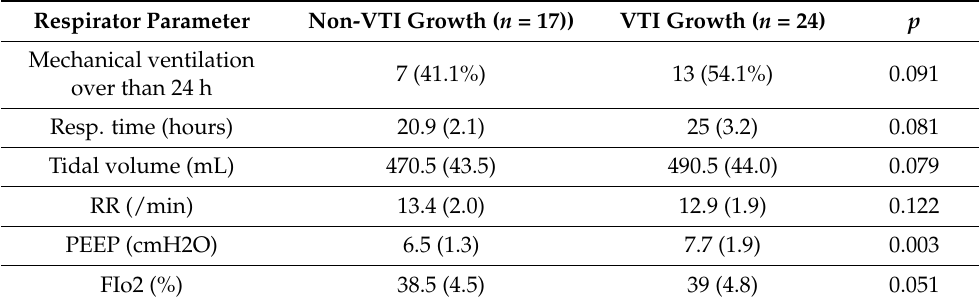
Table 3. Respiratory parameters.